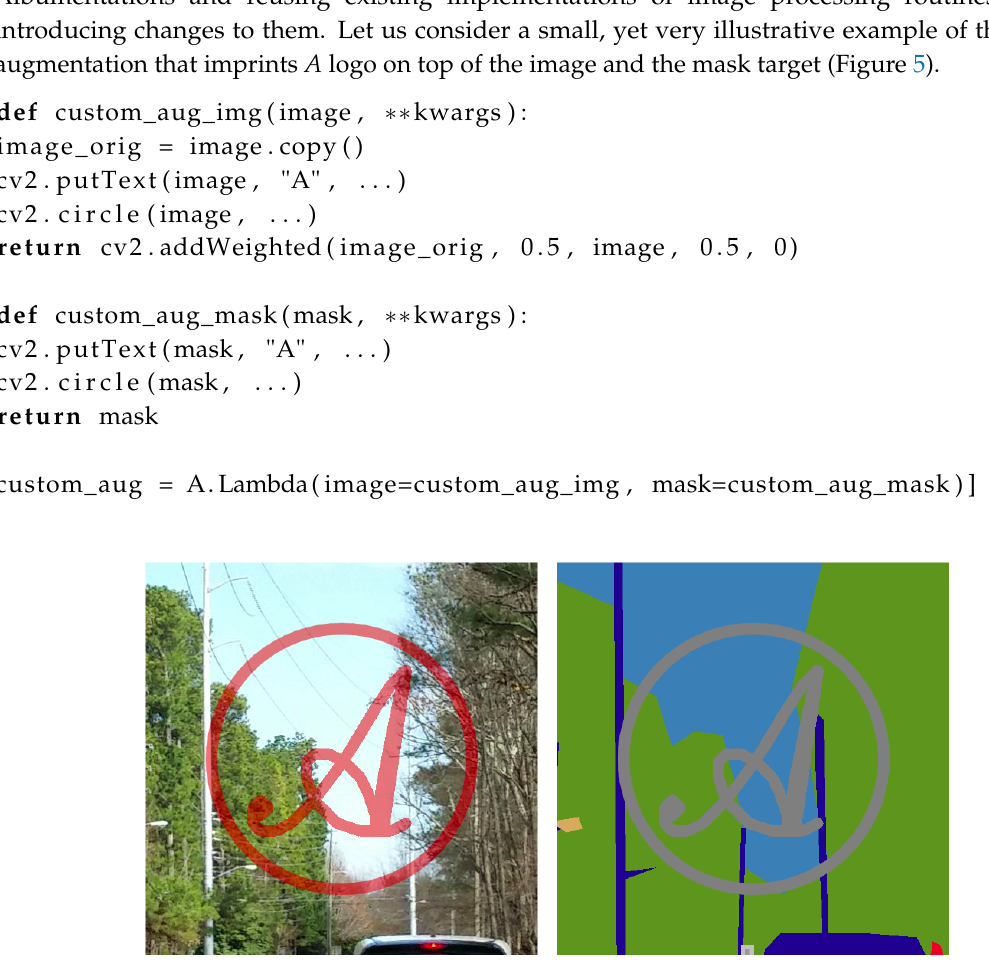
Figure 5. An example of applying a custom augmentation using A.lambda operator to an image ( left ) and a corresponding segmentation mask ( right